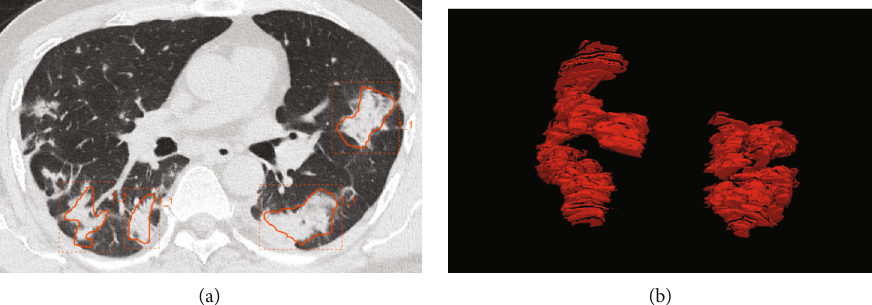
Figure 3: A case of con fi rmed severe COVID-19. A 45-year-old male presented with a 12-day history of fever, cough with expectoration, and mild dyspnea. (a). CT imaging revealed multiple consolidation with symmetric distribution in both lungs. The area of the lesions was delineated on the axial. (b) The reconstructed